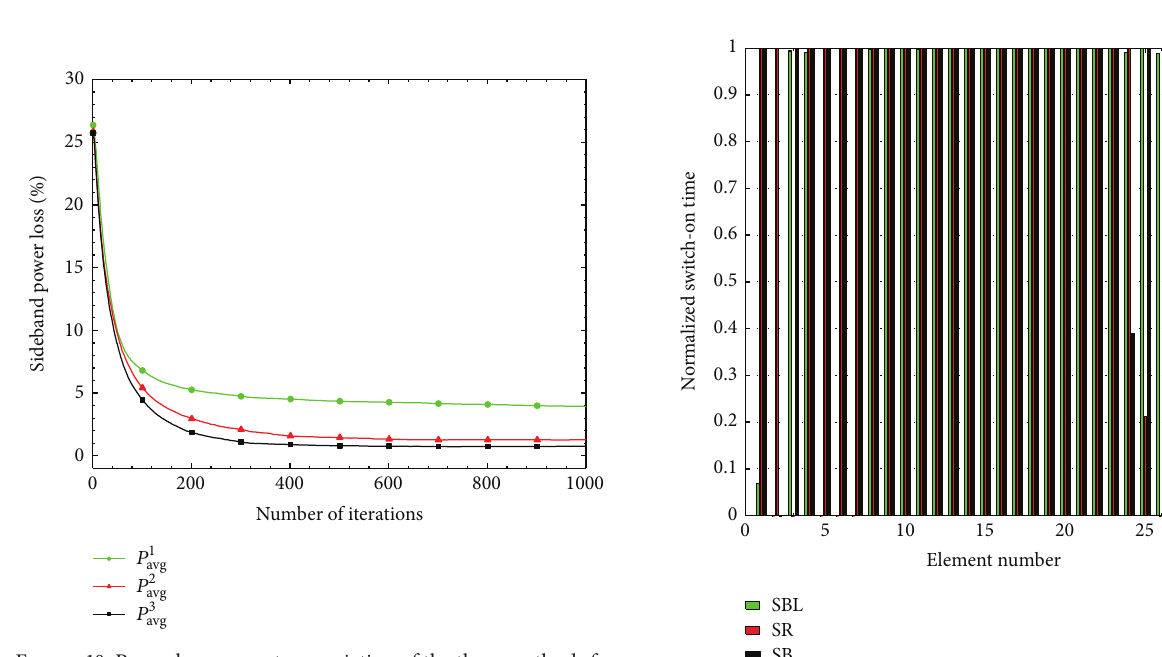
Figure 10: Power loss percentage variation of the three methods for IS— 𝑃 𝑘 represents the power loss percentage and 𝑘 represents the method used, where 𝑘 = 1 : SBL, 𝑘 = 2 : SR, and 𝑘 = 3 : SB.